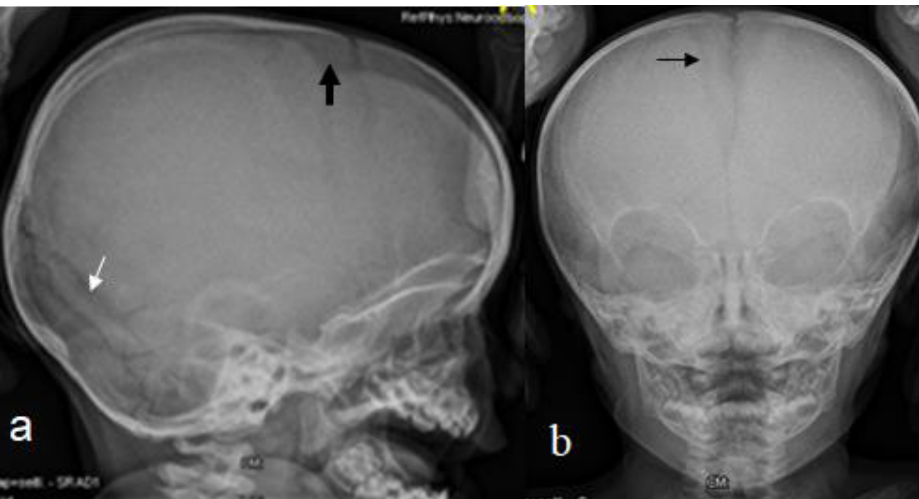
Figure 4. Lateral skull radiograph of a 14-month-old boy with RSS showed a very large anterior fontanelle (massive defective ossification) associated with frontal bossing, giving the impression of pseudo-hydrocephalus-arrow hyperostosis of the skull base and Wormian bones along the lambdoid sutures ( a ). AP skull radiograph showed the frontal bossing and the persistence of the anterior fontanelle-arrow ( b ).